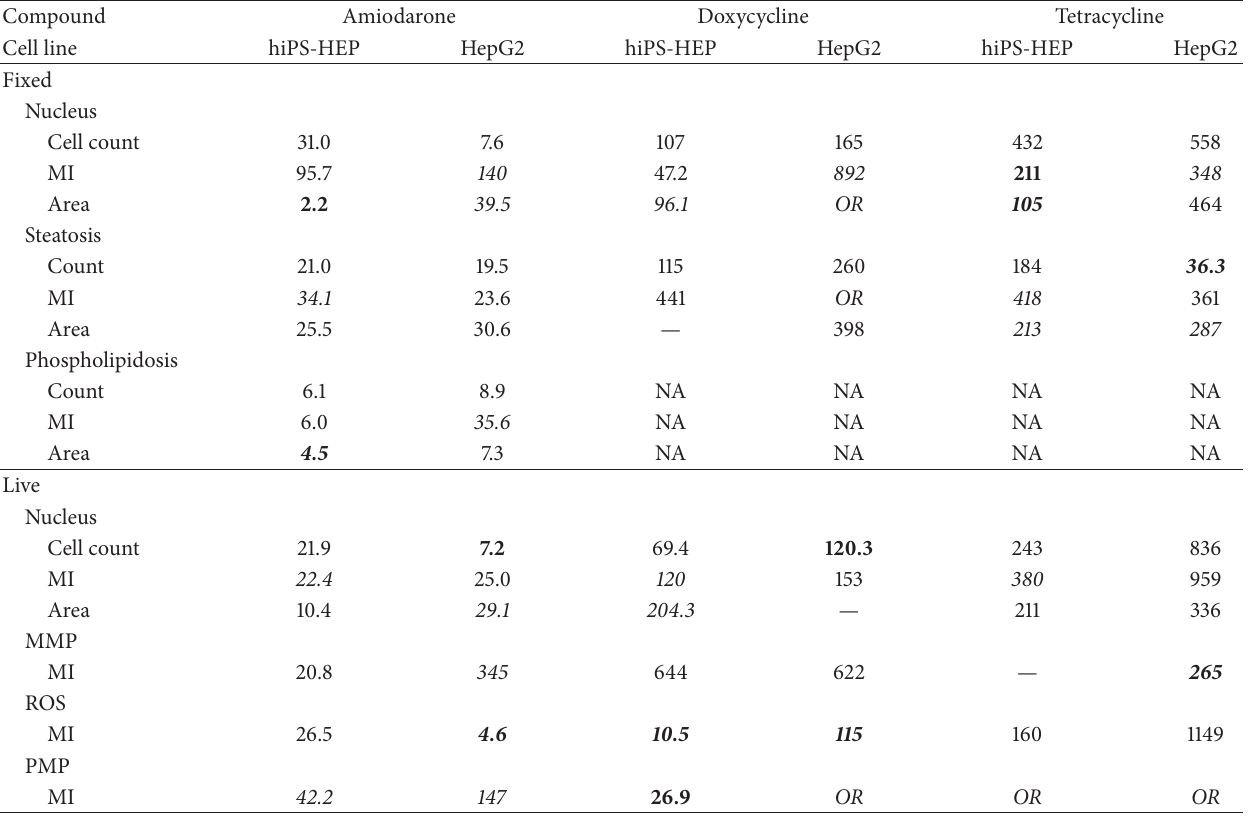
Table 2: IC 50 /EC 50 values for drug induced effects on different parameters measured in hiPSC derived hepatocytes (hiPS-HEP) and HepG2.